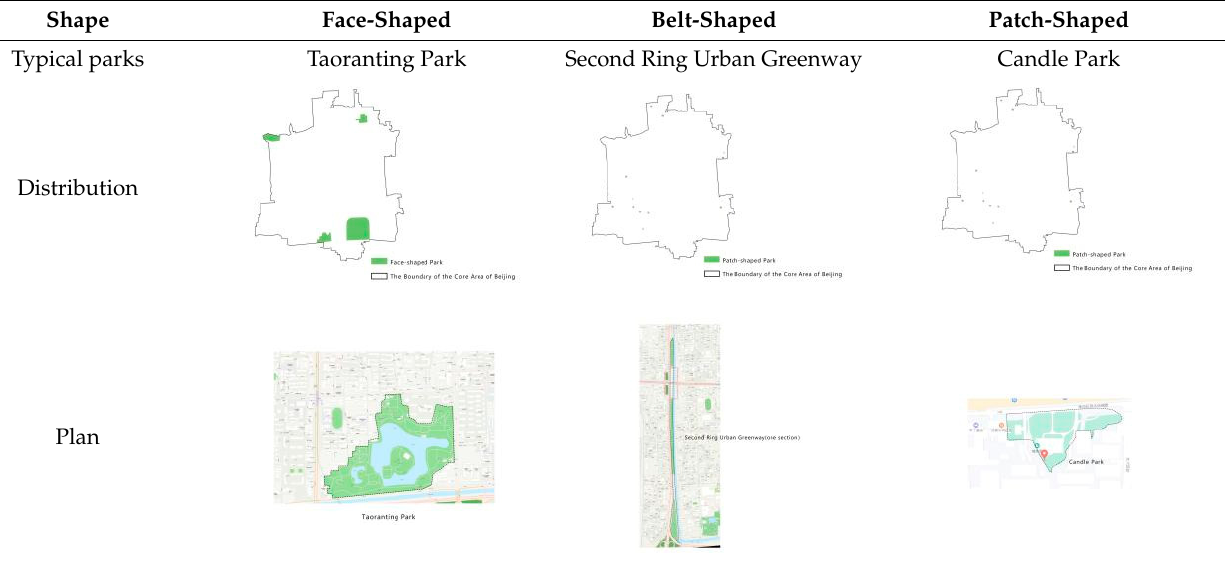
Table 8. Park shape classification and plan.